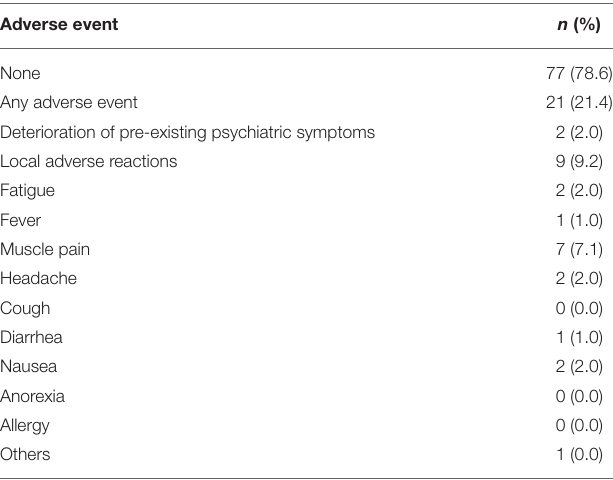
TABLE 4 | Adverse events after getting the COVID-19 vaccine among the 98 COVID-19 vaccine-recipients. Adverse event n (%) None 77 (78.6)